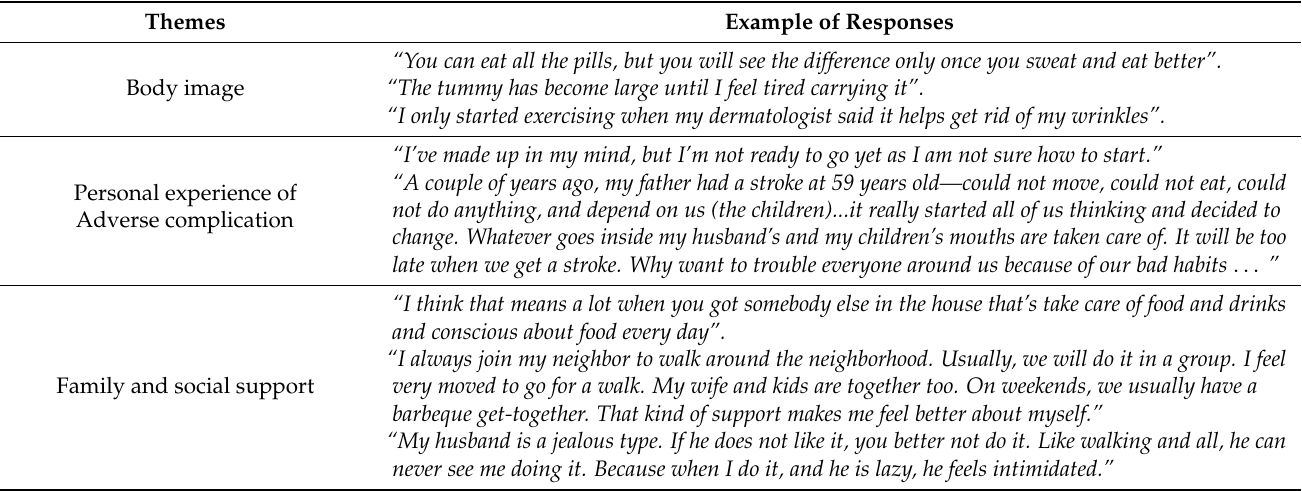
Table 2. Themes derived from responses given by study respondents (N = 21) in the domain of perceived